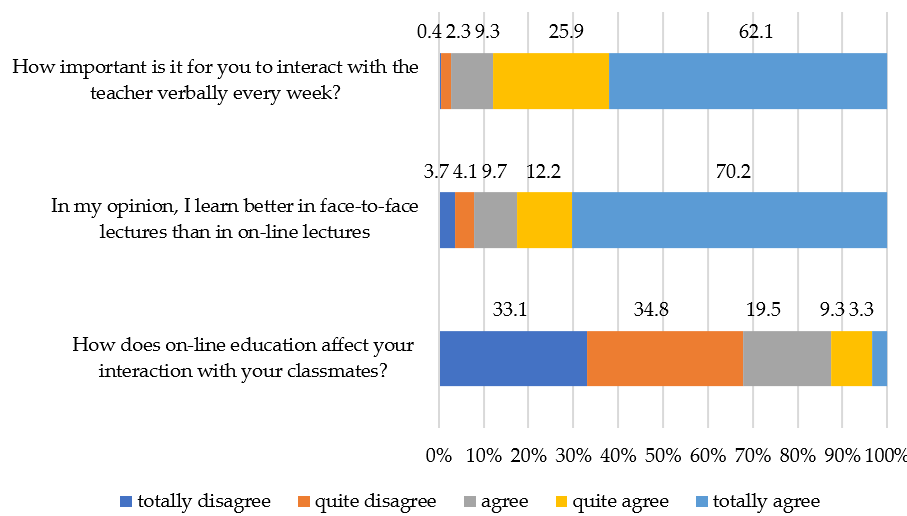
Figure 4. Level of ability to adapt to online teaching linked to the construct of student autonomy.